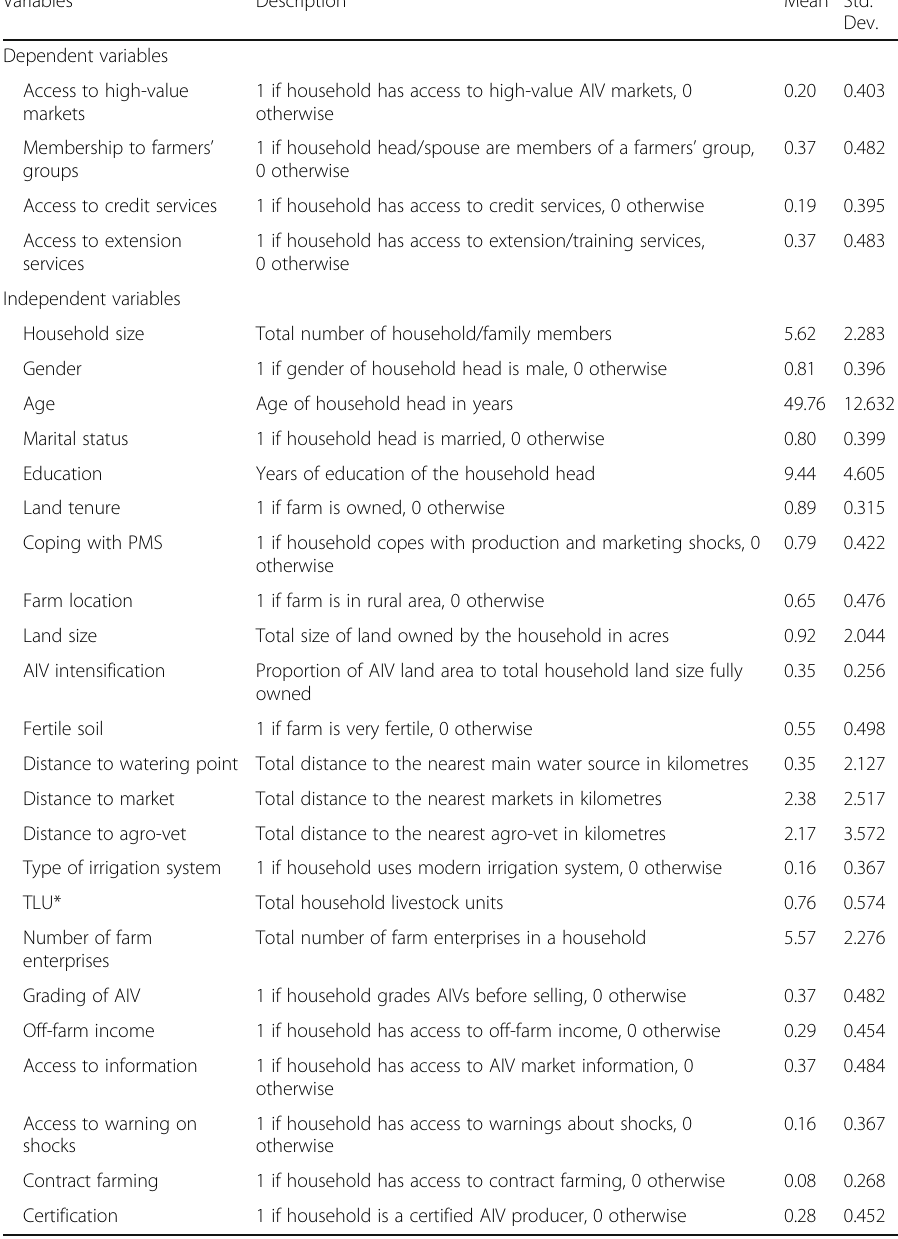
Table 1 Description and summary statistics of selected variables Variables Description Mean Std.